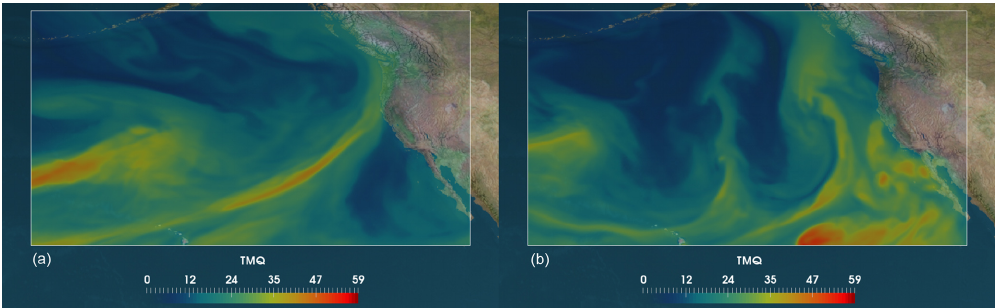
Figure 12. Sample images of events from the testing set showing a typical failure mode of the proposed method: examples of ARs misclas- sified as non-ARs (false negatives). The figure shows IWV (kgm − 2 ) in the CAM5.1 climate model (color map) and the land–sea mass as background (satellite image). (a) The model fails likely because there are two separate events in the figure; one is a fully formed AR and the other is the start of a new AR. (b) The method fails likely due to imperfect training data. The ground truth data from TECA label this image as an AR, although (visually) it does not appear to satisfy the definition of an AR. This illustrates how imperfect training data, due to limitations of the algorithm used to produce ground truth data, impact the performance of the ML model.